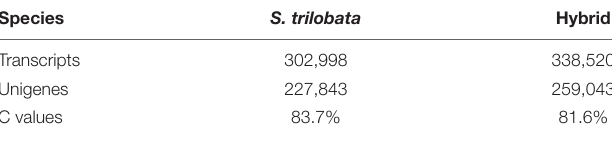
TABLE 1 | De NOVA results of leaves of two species after Cd stress